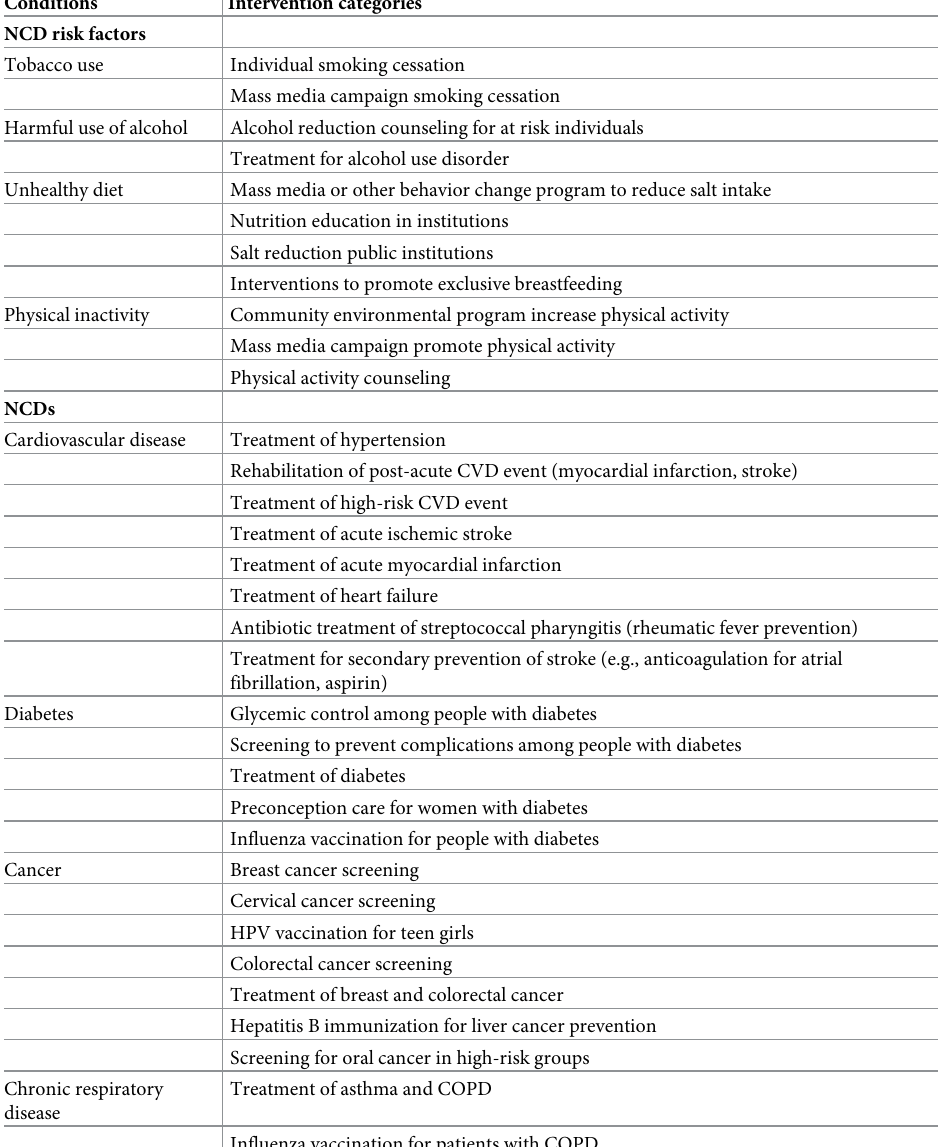
Table 2. Summary of eligible NCD preventive and control interventions. AU : AbbreviationlistshavebeencompiledforthoseusedinTables 1 and 2 : Pleaseverifythatallentriesarecorrect :